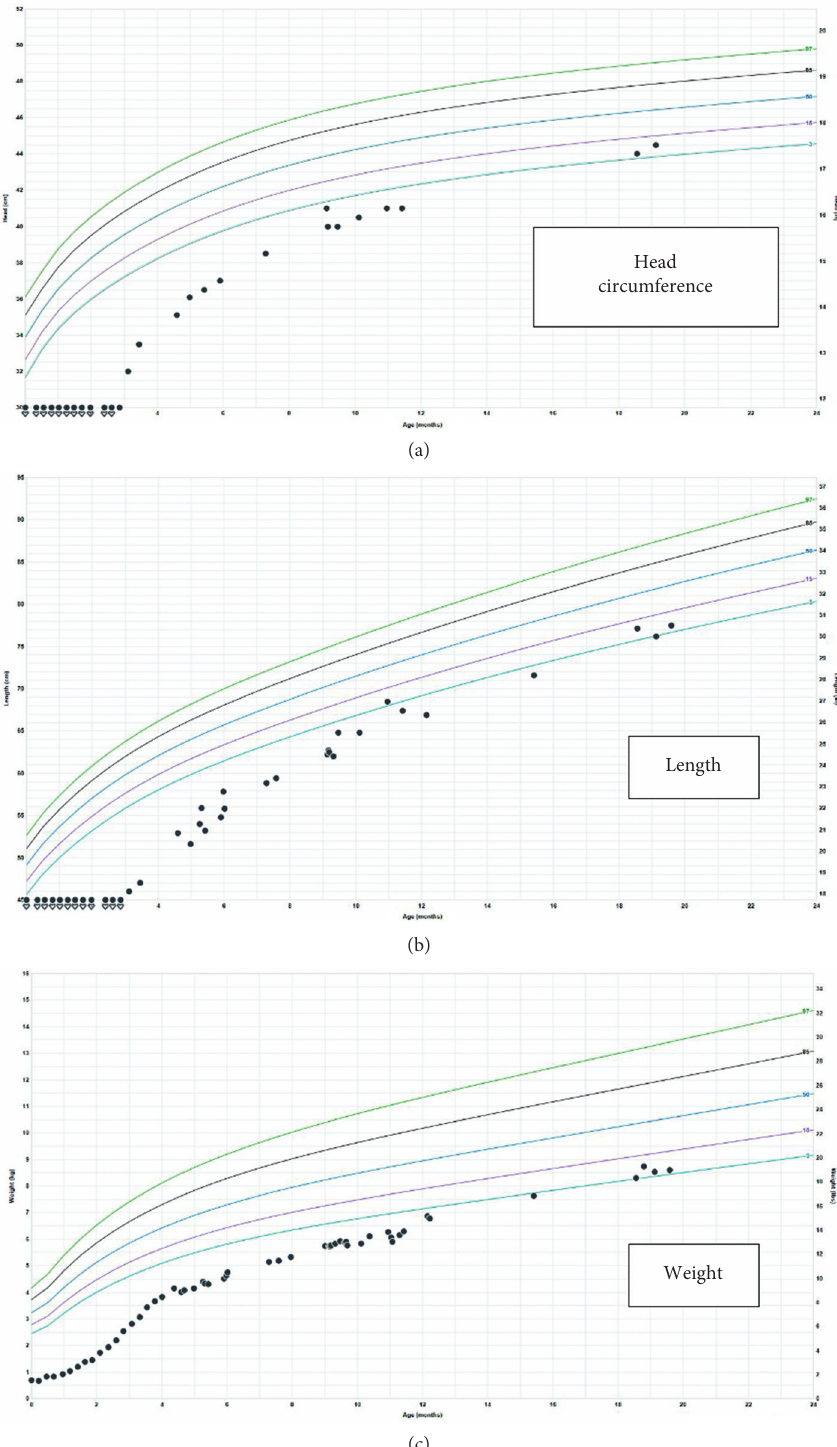
Figure 3: Growth in (c) weight, (b) length, and (a) head circumference of the child from birth to 20